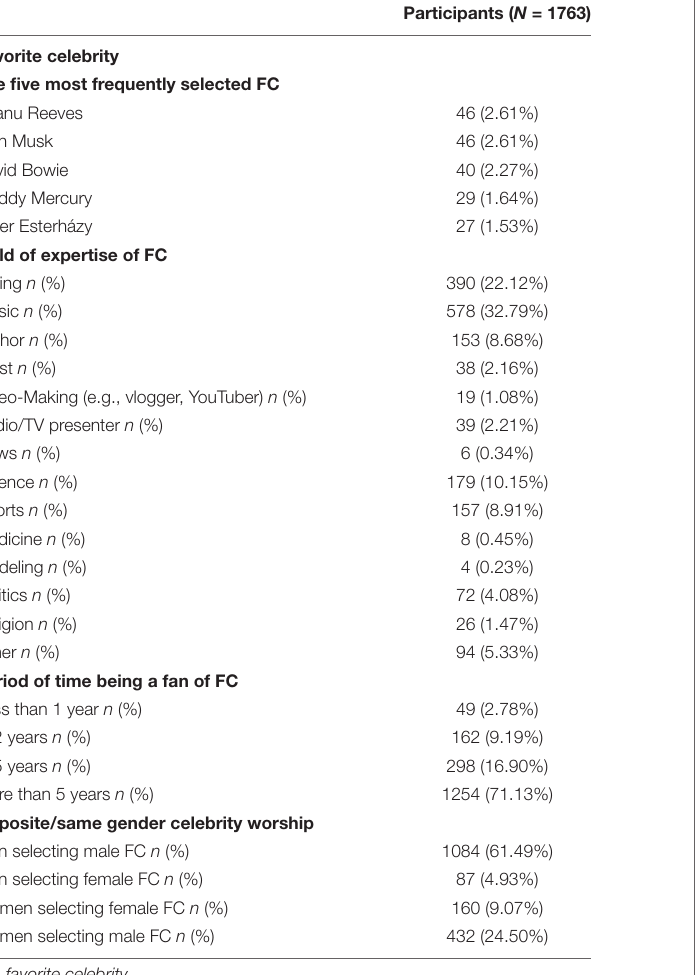
TABLE 2 | Descriptive statistics for variables exploring the interest for a favorite celebrity in the present